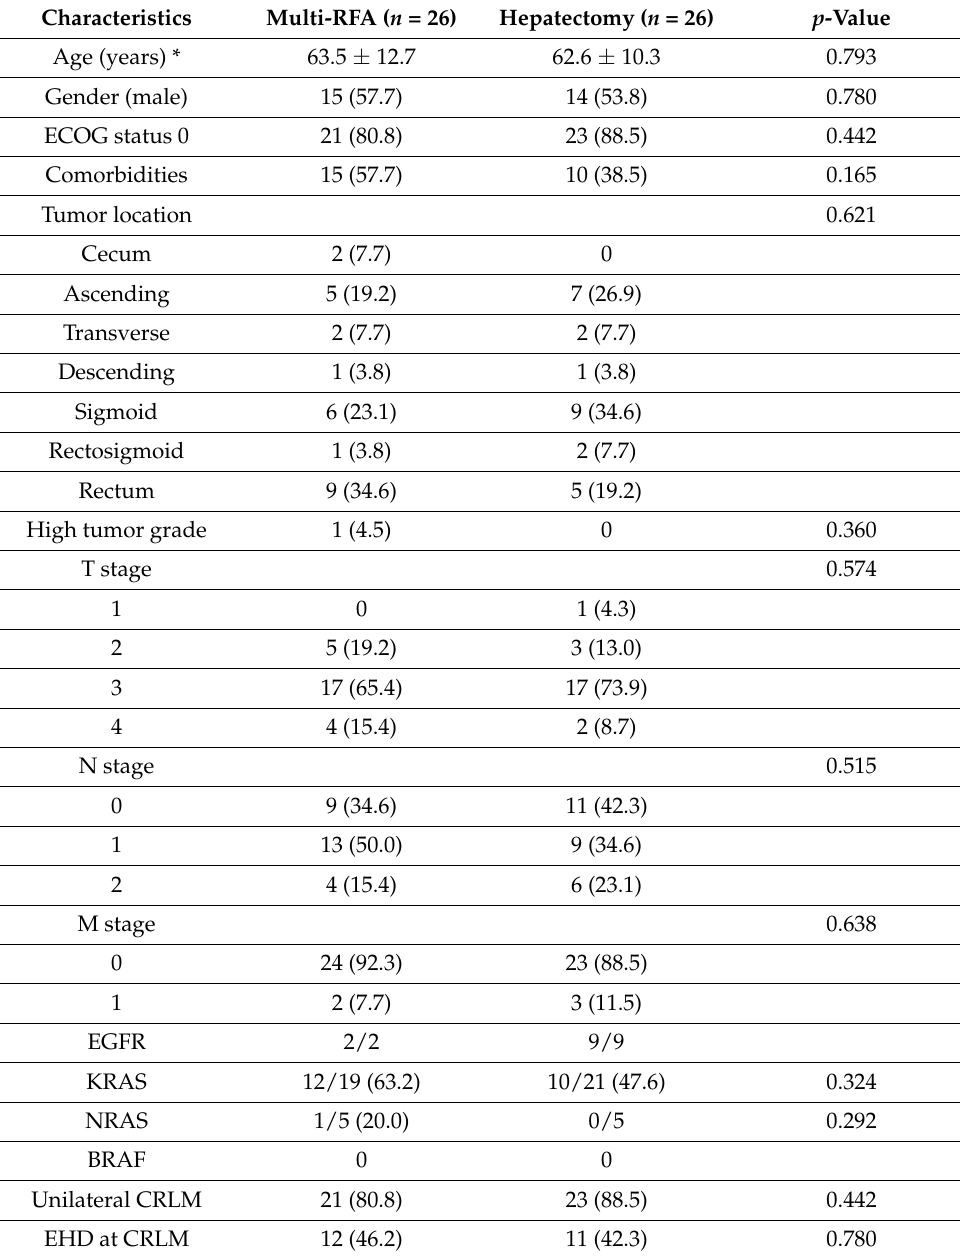
Table 6. Clinicopathological characteristics after